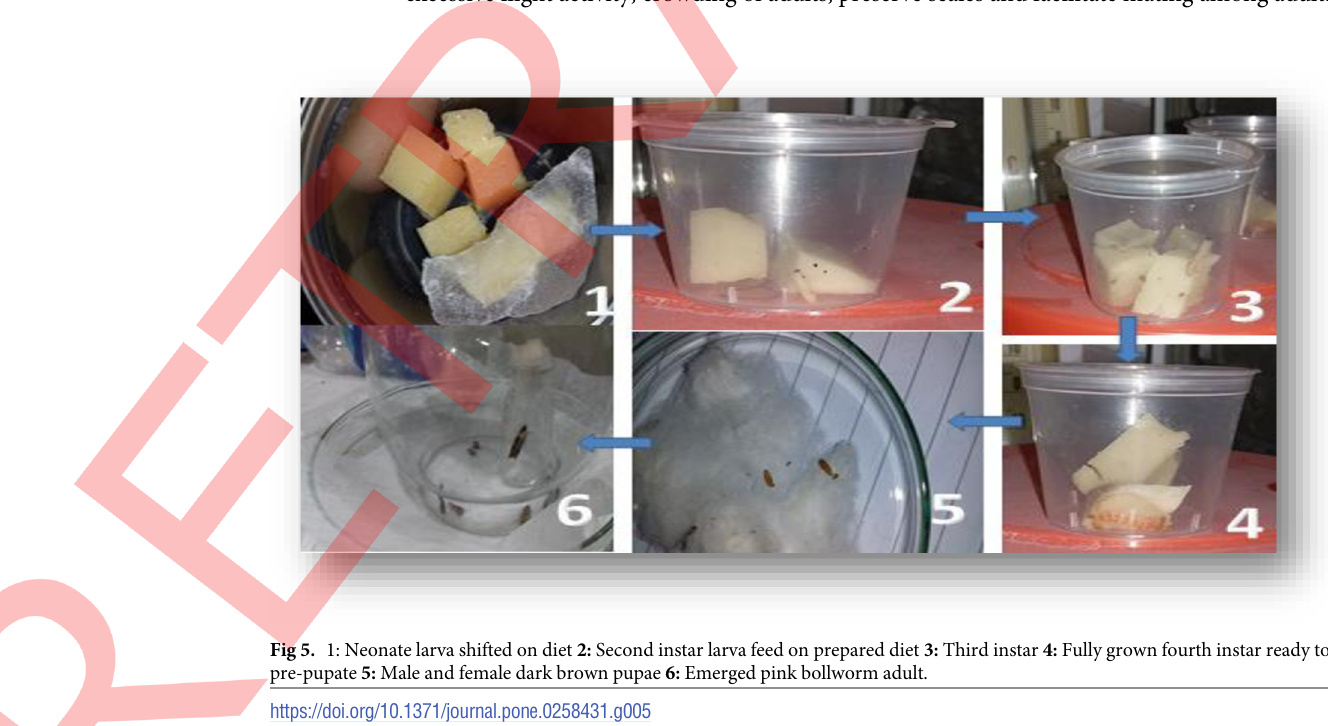
as reared containers to prevent larval escape, predator entry, diet contamination, and dehydra- tion. Marked transparent plastic cups replicated 10 times for each treatment diet and using camel’s hair brush released freshly emerged neonates onto diet cubes at 2 larvae/cup and reared until pupation. For successful larval development, larvae shifted onto a fresh diet (Fig 5) for every third day while daily observed larval stage and increased diet according to the larval stage. The fourth stage larvae were sexed, weighed, and counted separately for adult pairing. Upon pupation, the pupae were weighed and transferred dark brown pupa in wide-mouthed specimen jars labelled as male and female for separate adult emergence and collection. After the pupation, the emerged adults were released in pairs into oviposition glass chimneys for mating and egg-laying purpose. Wide-mouthed round glass chimneys were used to prevent excessive flight activity, crowding of adults, preserve scales and facilitate mating among adults.